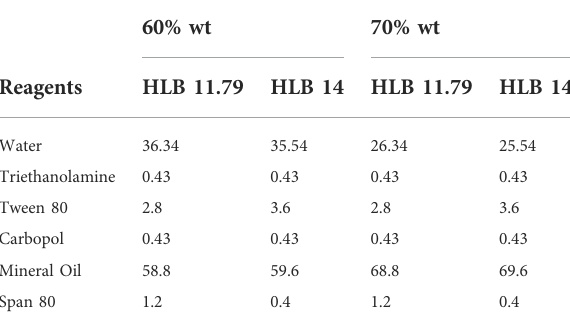
TABLE1ListofreagentsandcompositionofthebareO/Wemulsionat two different concentrations of the dispersed phase and two different HLB values: 60 % wt. and 70 % wt. and HLB of 11.79 and 14. Composition of O/W emulsions